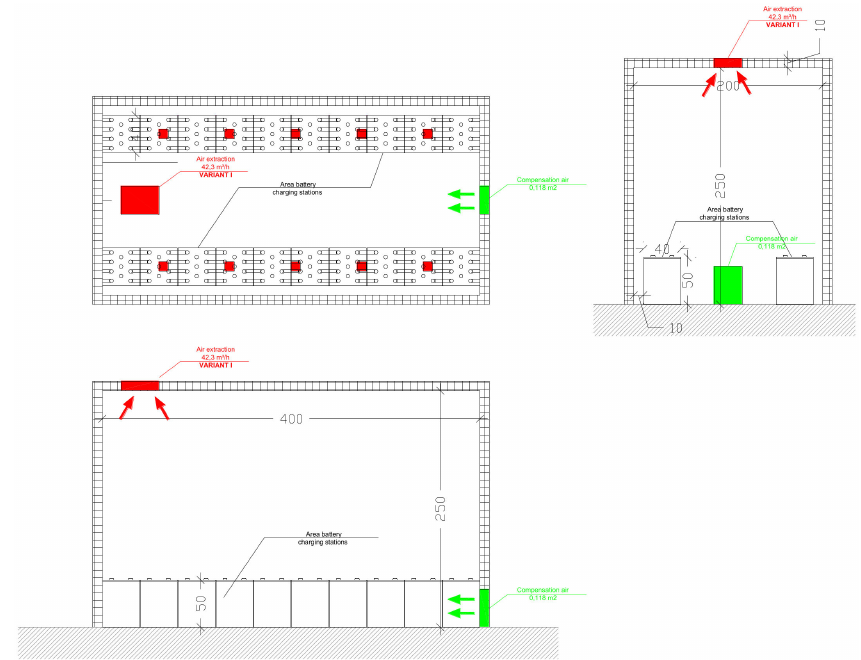
Figure 7. The mechanical ventilation system scheme with exhaust point in the ceiling and supply point near the